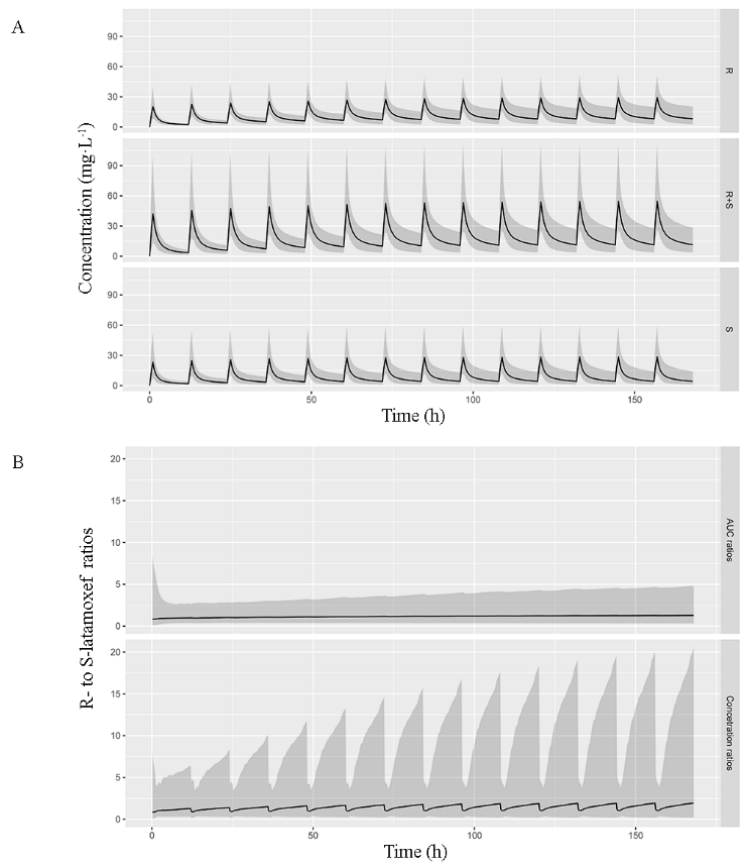
Figure 3. Predicted median exposure of R-, S-, and total latamoxef over time after multiple doses. ( A ) Simulation plot of predicted concentrations of R-, S-, and total latamoxef over time. The black line indicates the median, while the gray shaded area represents the 10th to 90th percentiles. ( B ) Variation interval of both AUC ratio and plasma concentration ratio of R- to S-epimer. The black line indicates the median. In the gray shaded area, the bottom represents the ratio of 10th percentile of R-epimer to 90th percentile of S-epimer, while the top represents the ratio of 90th percentile of R-epimer to 10th percentile of S-epimer.